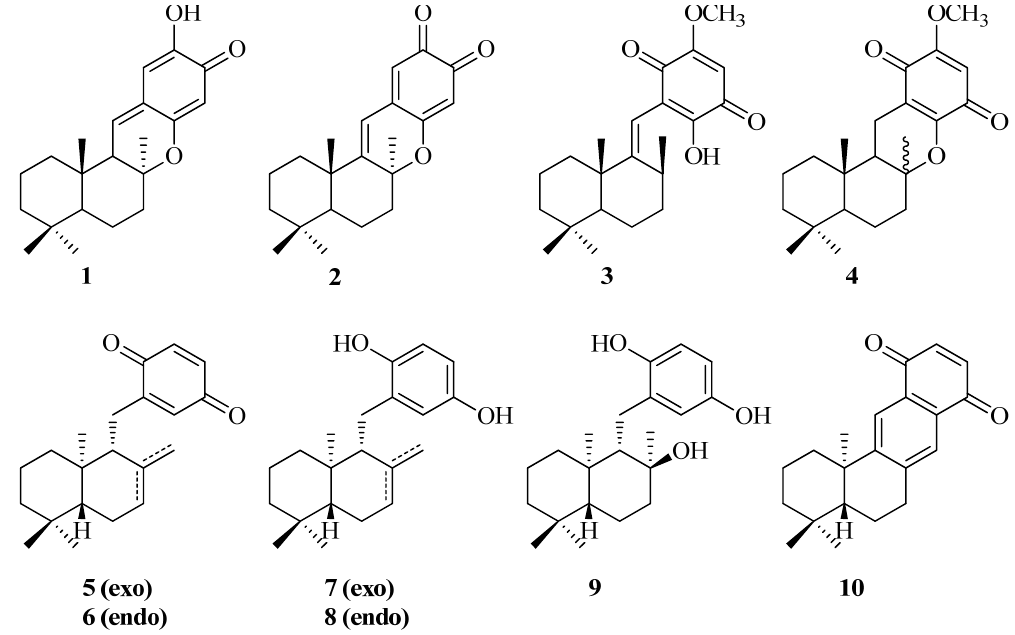
Figure 1. Some examples of natural